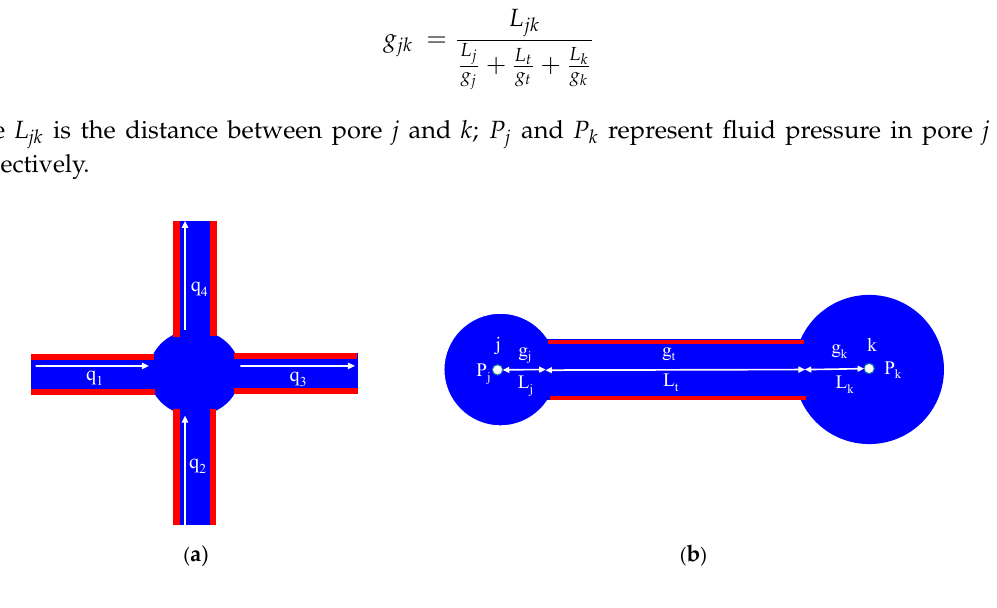
Figure 15. Scheme of pore network model (red part represents boundary layer while blue part represents the effective flow space): ( a ) Flow through every pore; ( b ) Conductance between two neighboring